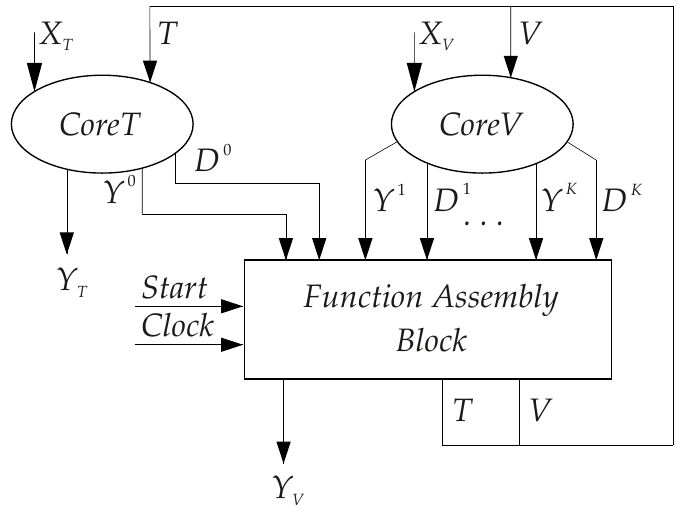
Figure 4. Generalized diagram of P 2 C Mealy